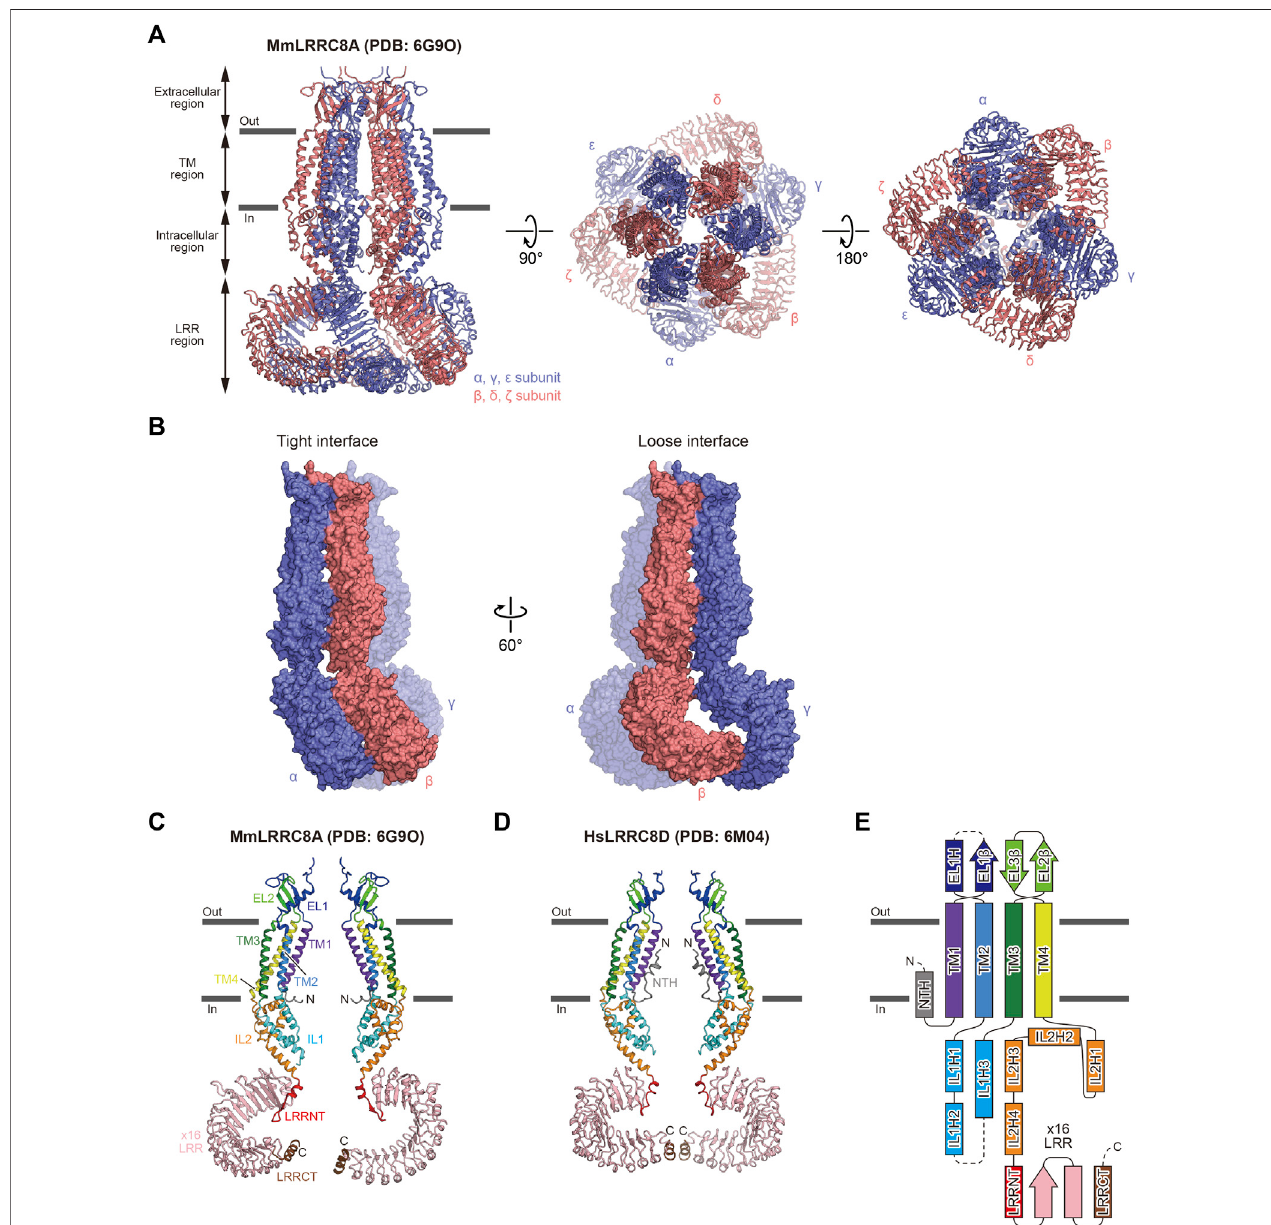
FIGURE1| Overallstructure and subunitinteractionsofLRRC8. (A) Overallstructure oftheMmLRRC8A hexamerindetergent (PDB:6G9O)(Denekaet al.,2018), viewed parallelto the membrane (left) and from the extracellular (middle) and intracellular (right) sides (B) Tight (left) and loose (right) subunit interfaces between the three neighboringsubunitsoftheMmLRRC8Ahexamerindetergent(PDB:6G9O)(Denekaetal.,2018) (C,D) TwodiagonalsubunitsoftheMmLRRC8Ahexamerindetergent (PDB: 6G9O) (Deneka et al., 2018) (C) and the HsLRRC8D hexamer in detergent (PDB: 6M04) (Nakamura et al., 2020) (D) . According to the previously proposed nomenclature (Kasuya et al., 2018; Nakamura et al., 2020), each region is colored as follows: NTH, N-terminal helix, gray; TM1, purple; EL1, blue; TM2, light blue; IL1, cyan; TM3, green; EL2, light green; TM4, yellow; IL2, orange; LRRNT, leucine-rich repeat N-terminal, red; LRR1 – 16, pink; and LRRCT, brown. The N and C termini are indicated by ‘ N ’ and ‘ C ’ , respectively (E) Schematic representation of the LRRC8 membrane topology, colored as in (C,D) . The dotted lines indicate the disordered linkers. Figures prepared with CueMol